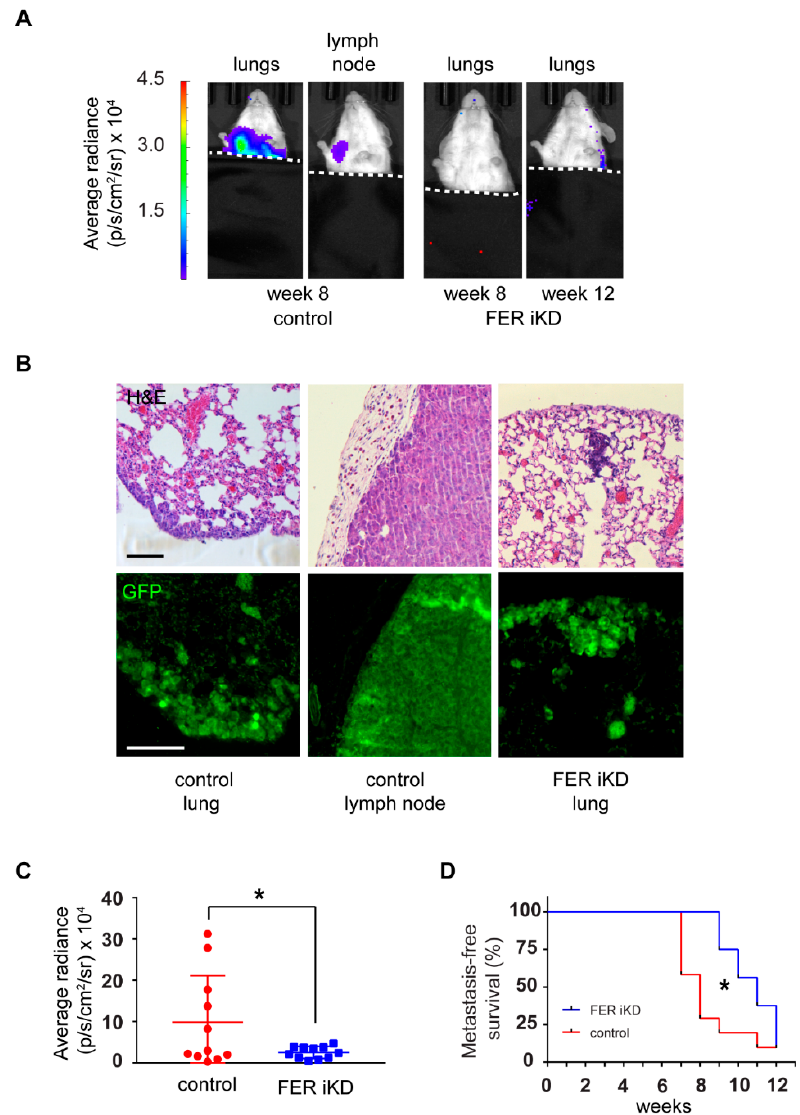
Figure 7. FER downregulation inhibits formation of melanoma distant metastases. ( A ) Bioluminescence imaging (BLI) of melanoma cell distant metastases in control and FER iKD tumor-bearing mice. The mice were covered during imaging to prevent interference from the signal emitted from cells in the primary tumor (the dotted line delineates the exposed and covered areas). ( B ) Lung and lymph node tissue sections were stained with hematoxilyn and eosin (H&E) and visualized with light microscopy. Immunofluorescence staining using an anti-GFP antibody was performed on adjacent tissue sections to confirm distant metastases of melanoma cells. Bar = 100 µ m. ( C ) Mean radiance ± SEM ( n = 11) of distant metastases of control and FER iKD tumor-bearing mice at endpoint. * represents p < 0.05 (Welch’s t test). ( D ) Metastasis-free survival analysis of control and FER iKD tumor-bearing mice ( n = 11). * represents p < 0.05 (Mantel-Cox